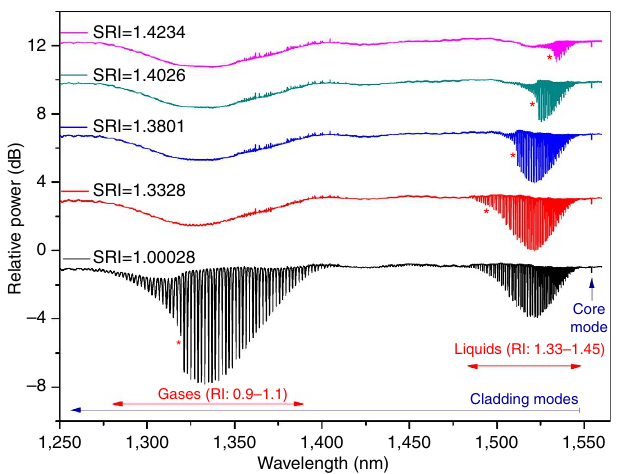
Figure 1 | Transmitted power spectra of an uncoated 16-mm-long 37 (cid:2) TFBG in air and liquids. Spectra measured for different surrounding refractive indices (SRIs) are plotted with an offset in the vertical scale. Red stars identify the cutoff wavelength in each medium.